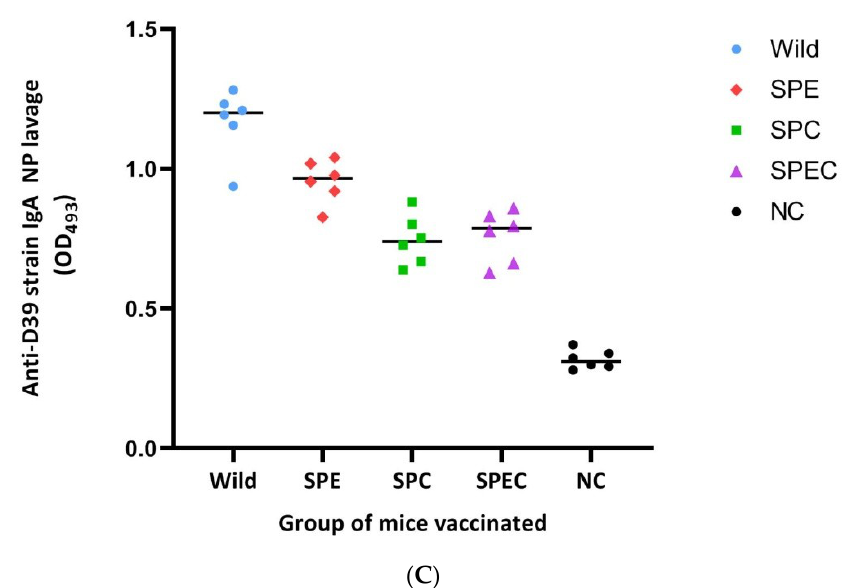
Figure 5. Comparison of the anti-D39 strain serum IgM ( A ), IgG ( B ), and NP lavage IgA ( C ) antibody levels of mice after vaccination with the indicated strains. The serum utilised was diluted to 1:100 and NP fluid was diluted to 1:10. Bars represent the respective mean values. The statistical analysis of antibody levels between the groups was performed using analysis of variance (ANOVA) followed by a post hoc Tukey’s test. In (A) , significant differences were found between groups SPEC and NC ( p < 0.05), between groups SPEC and SPC ( p < 0.01), and between groups SPE and SPC ( p < 0.05). In (B) , significant differences ( p < 0.01) were observed in all groups except between Wild-, SPC- and SPEC-immunised mice. In (C) , significant difference ( p < 0.01) were found in all groups except between SPC- and SPEC-immunised mice. Abbreviations used: Wild, S. pneumoniae D39 wild-type strain; SPE, S. pneumoniae D39 ( endA::aphA3 ) knockout strain; SPC, S. pneumoniae D39 ( cpsE::tetL )